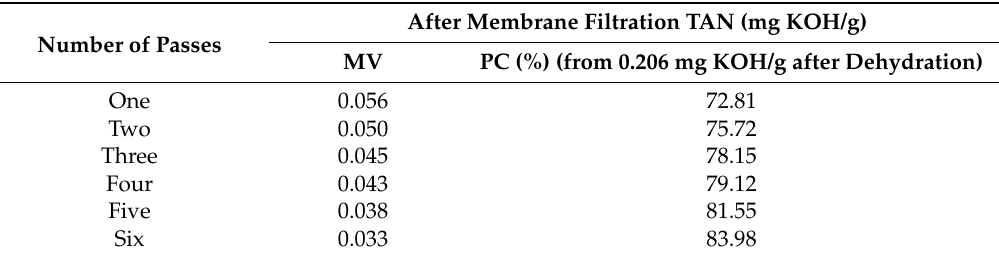
Table 2. Effect of RC membrane filtration on TAN with number of passes.